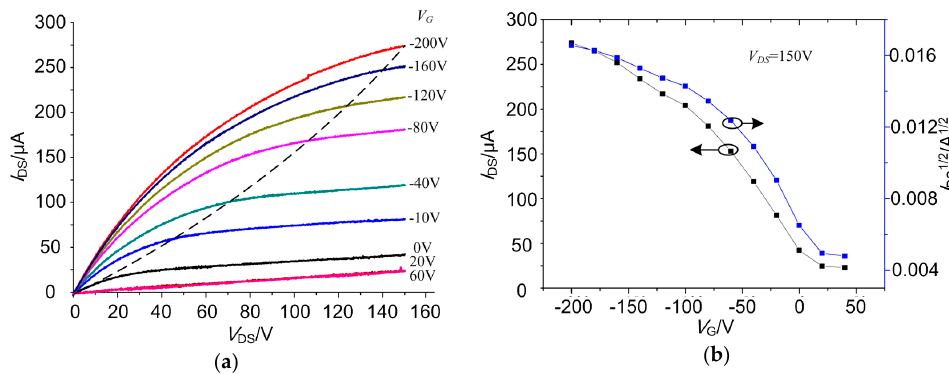
Figure 9. Performance of the RR-P3HT-based FET device: ( a ) output characteristic curve and ( b ) transfer characteristic curve.